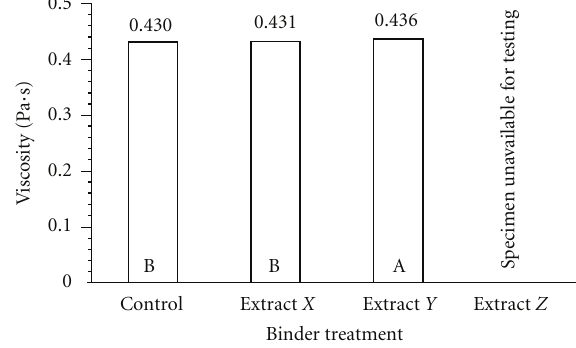
Figure 9: Viscosity of control binder and binder with finish extracts (no fibers) tested at 135 ◦ C.